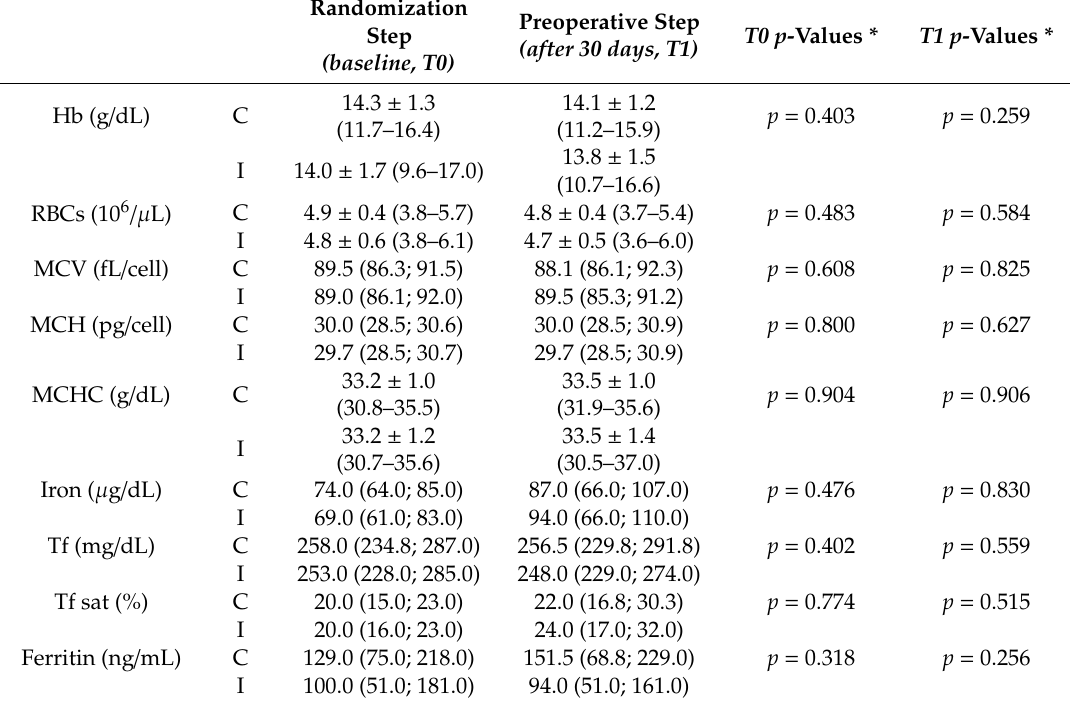
Table 2. Biochemical markers of martial status in patients randomized to control group (C) or treatment group (I) with 30 mg of sucrosomial ferric pyrophosphate and 70 mg of L-ascorbic acid daily during 30 days prior to hip or knee